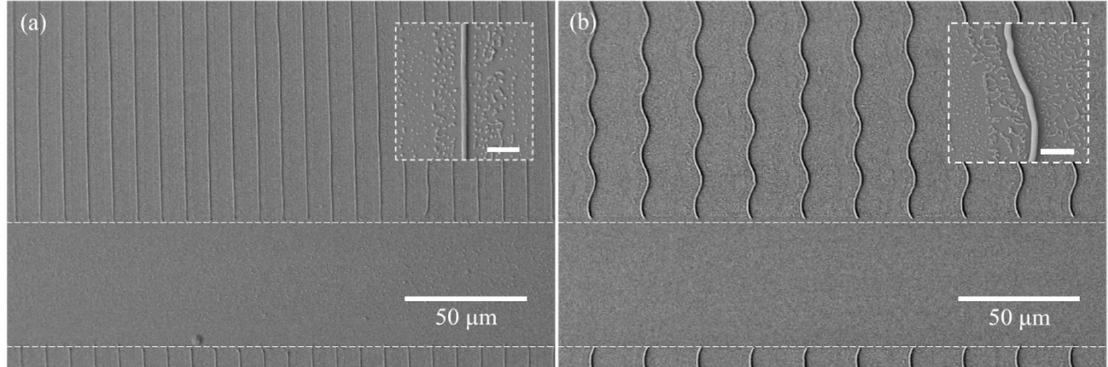
Figure 9. Oblique long dotted ( a ) linear and ( b ) wavy line structures. (Scale bar in the small box = 3 µ